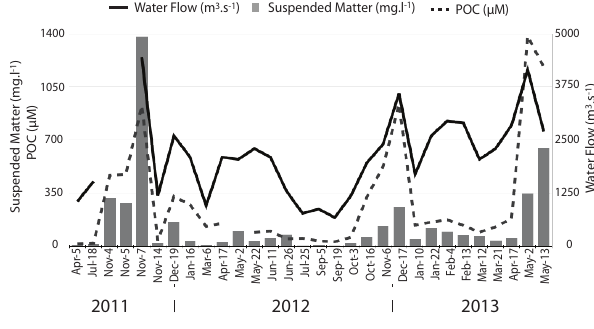
Figure 2. Water flow (m 3 s − 1 ) , suspended particulate matter (mgL − 1 ) and particulate organic carbon (POC, µM) of Rhône wa- ters on our sampling dates (MOOSE data). Samples span a wide range of water flow